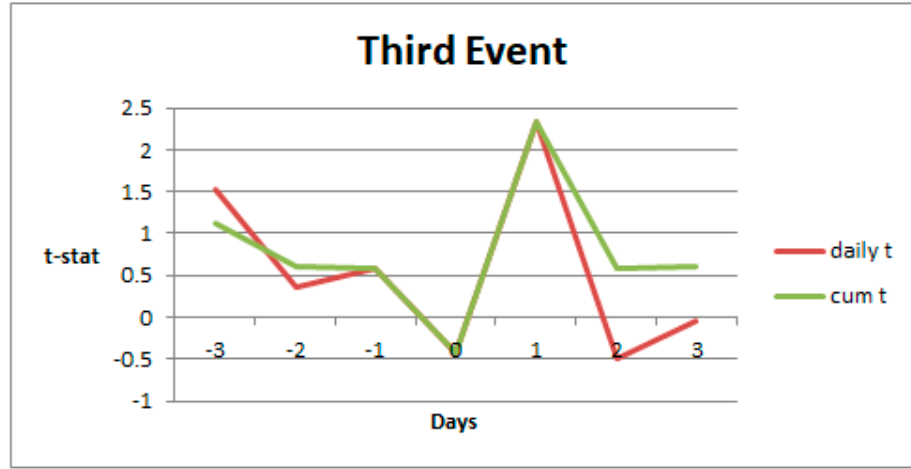
Figure 3. Daily t for AAR and cumulative t for CAAR. Source: Authors’